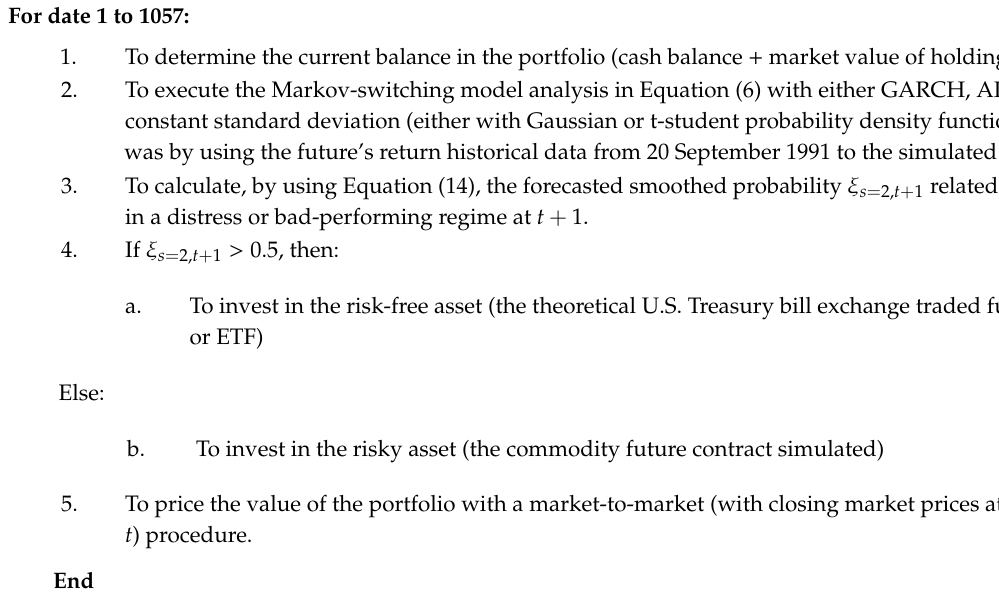
Algorithm 1. The MS-GARCH based trading algorithm’s pseudocode. For date 1 to 1057: